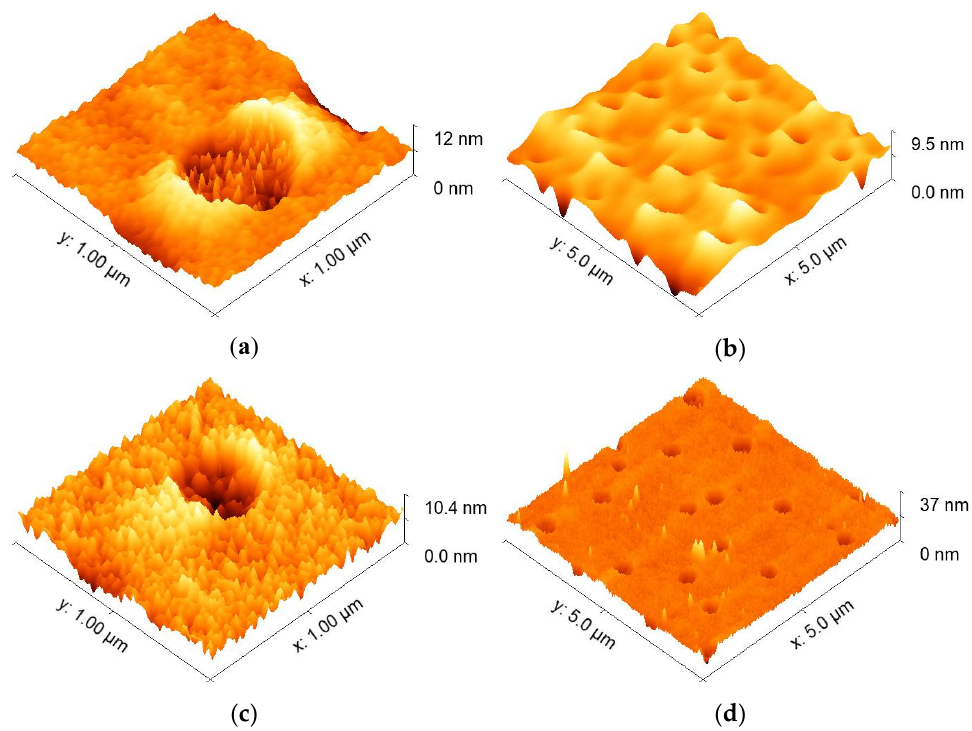
Figure 2. AFM images of the polymer surface before ( a , b ) and after the plasma cleaning procedure ( c , d ). The images correspond to the same sample, at different scanning areas.